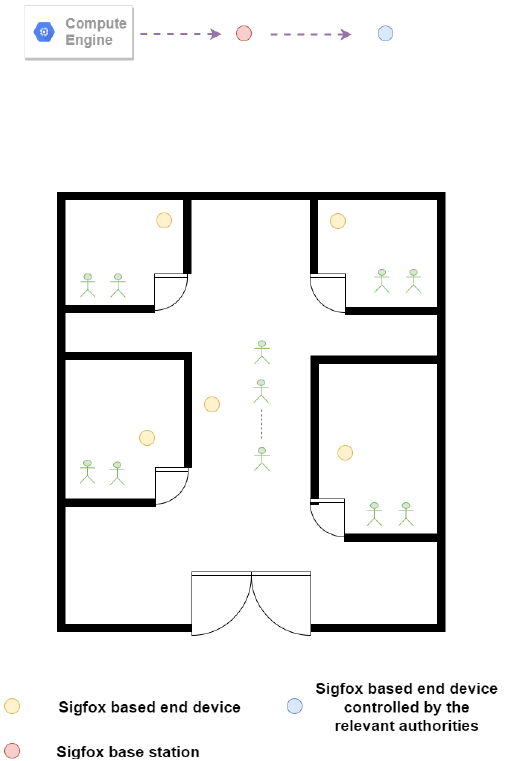
Figure 7. Case study using Sigfox technology for downlink data transmission to alert the authorities.